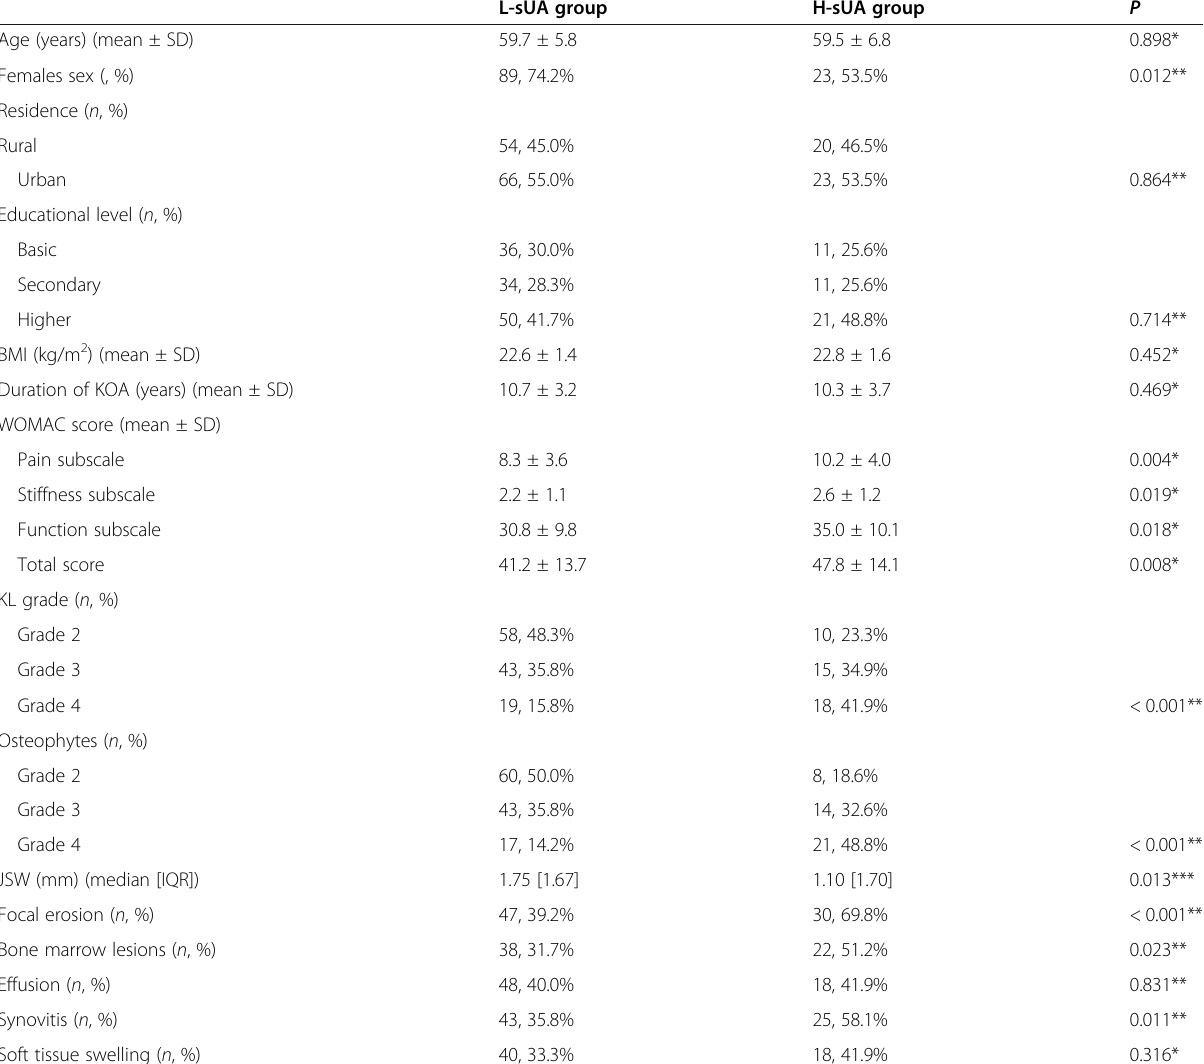
Table 1 Comparison of socio-demographic characteristics, clinical findings, and radiological findings between knee osteoarthritis patients in low serum uric acid group versus high serum uric acid